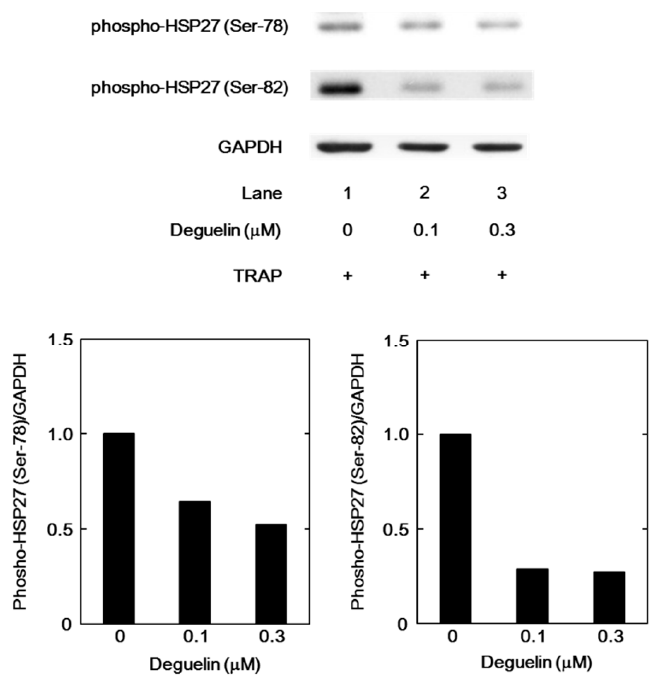
Figure 7. The effect of degueline on the TRAP-induced phosphorylation of HSP27 in the platelets from a healthy subject. PRP from a healthy subject was pretreated with various doses of deguelin for 15 min and then stimulated by 20 µM of TRAP at 37 °C for 4 min. The reaction was terminated by the addition of an ice-cold EDTA (10 mM) solution. The lysates of platelets were subjected to a Western blot analysis making use of antibodies against phospho-specific HSP27 (Ser-78 and Ser-82) and GAPDH. The bands were quantified by ImageJ as the counts of pixels. The bands of phospho-HSP27 were normalized to the GAPDH bands. The ratio is presented for each value. The upper panel indicates the bands of Western blot, and lower panels indicate each ratio.